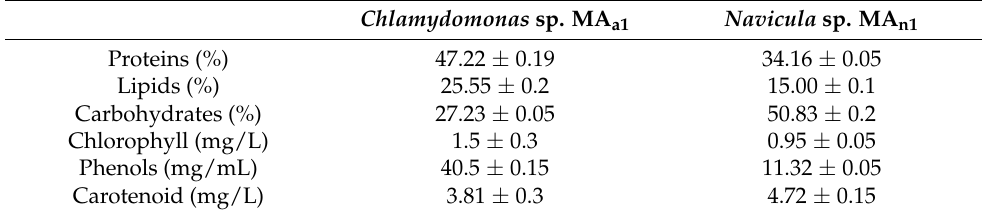
Table 1. Microalgae biomass composition.